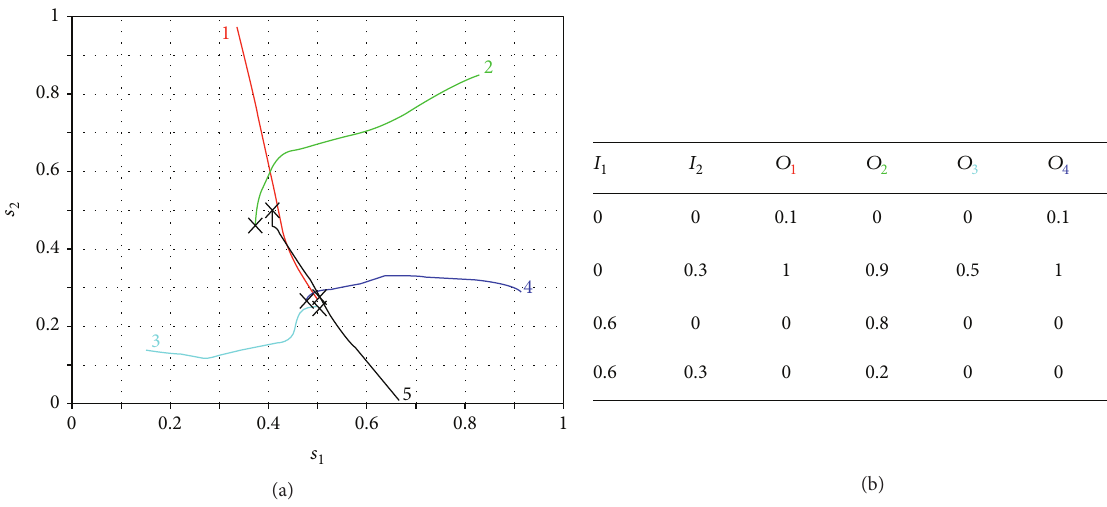
Figure 5: Evolution of gate circuit parameters with only intrinsic plasticity. (a) Evolution of the shift parameters of neurons 1 (SG) and 2 (CT) in five different simulations (different line colors). Crosses represent the values of shift parameters at the last iteration. (b) Truth table after each one of the simulations. Colors in the indexes refer to the same color curves in (a).